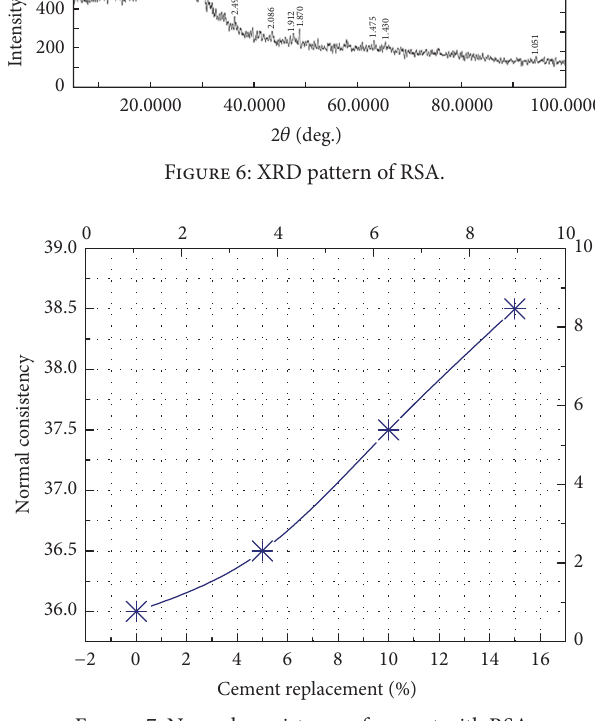
Figure 7: Normal consistency of cement with RSA.